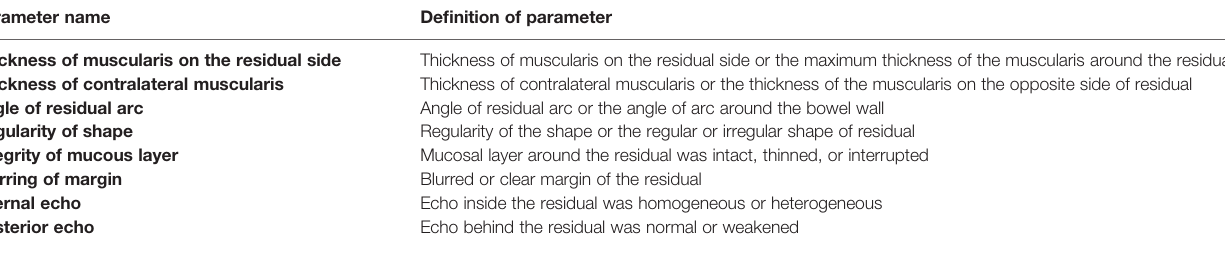
TABLE 1 | De fi nition of 3D-TRUS